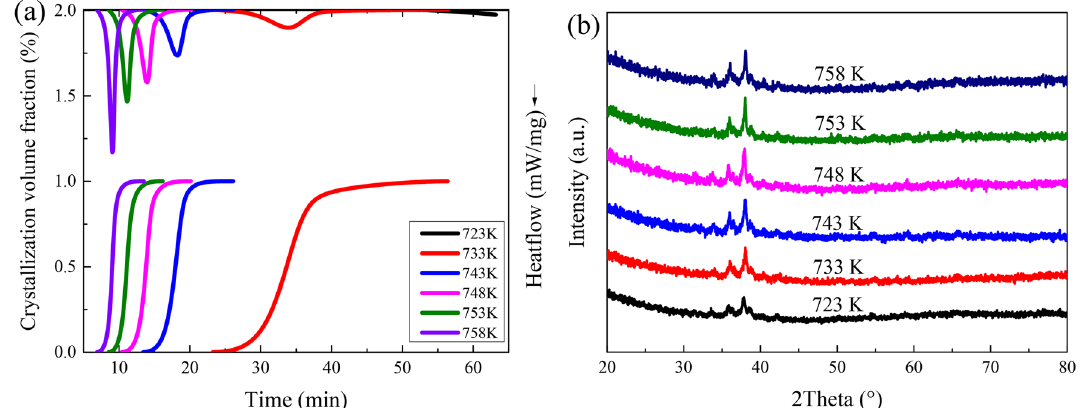
Figure 2. ( a ) Isothermal DSC scans at the top and the crystallization volume fraction at the bottom, ( b ) XRD patterns of the specimens after annealing at the given temperatures.